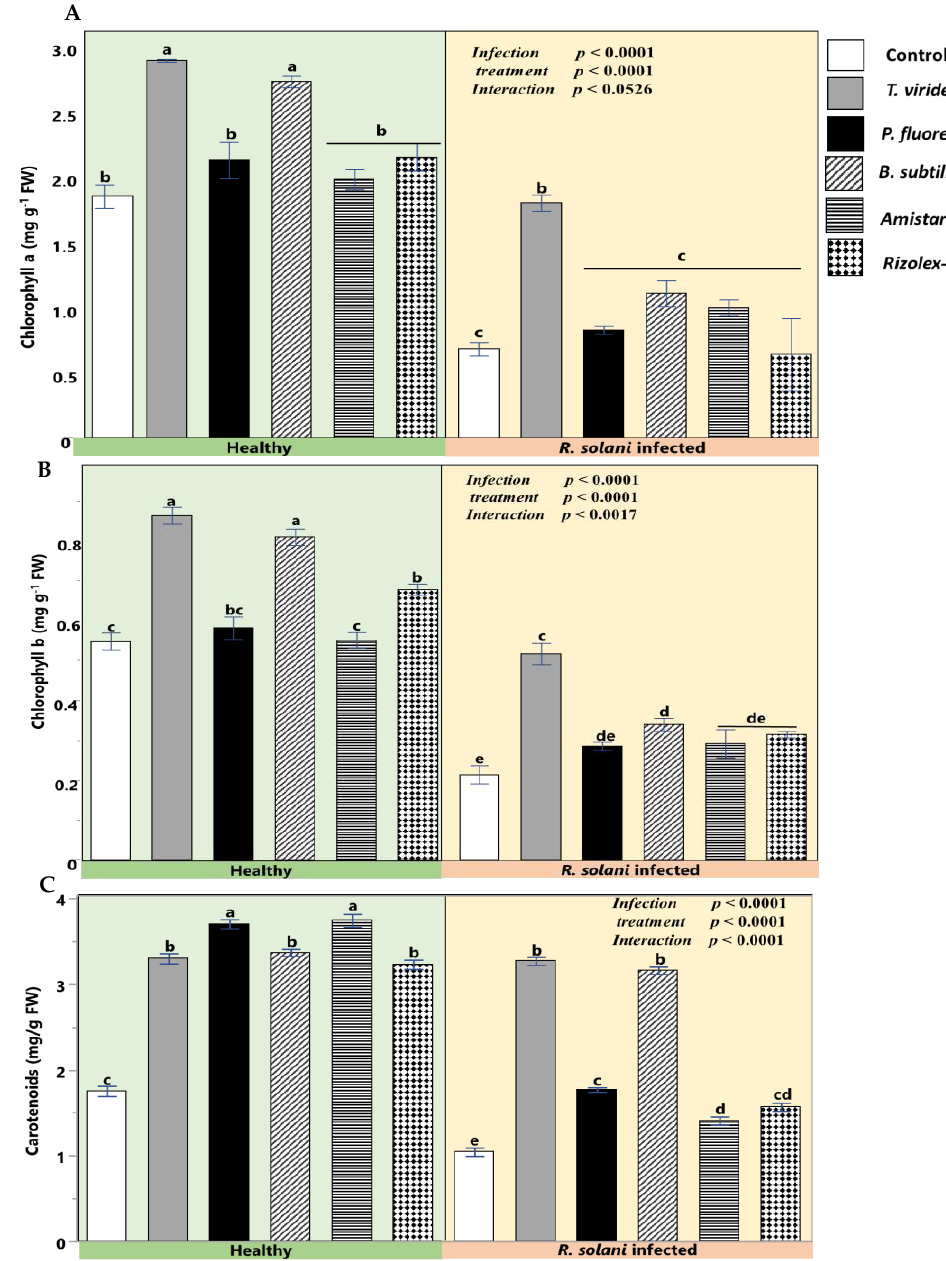
Figure 6. Biocontrol agents’ effect on coriander photosynthetic pigment content under infection by R. solani. ( A ) Chlorophyll a (mg g − 1 FW), ( B ) Chlorophyll b (mg g − 1 FW), and ( C ) Carotenoids (mg g − 1 FW). Data presented are the means ± the standard deviation (mean ± SD) of five biological replicates. Different letters indicate statistically significant differences among treatments, while the same letters signify no significant differences between them according to a Tukey’s honestly significant difference test ( p < 0.05).